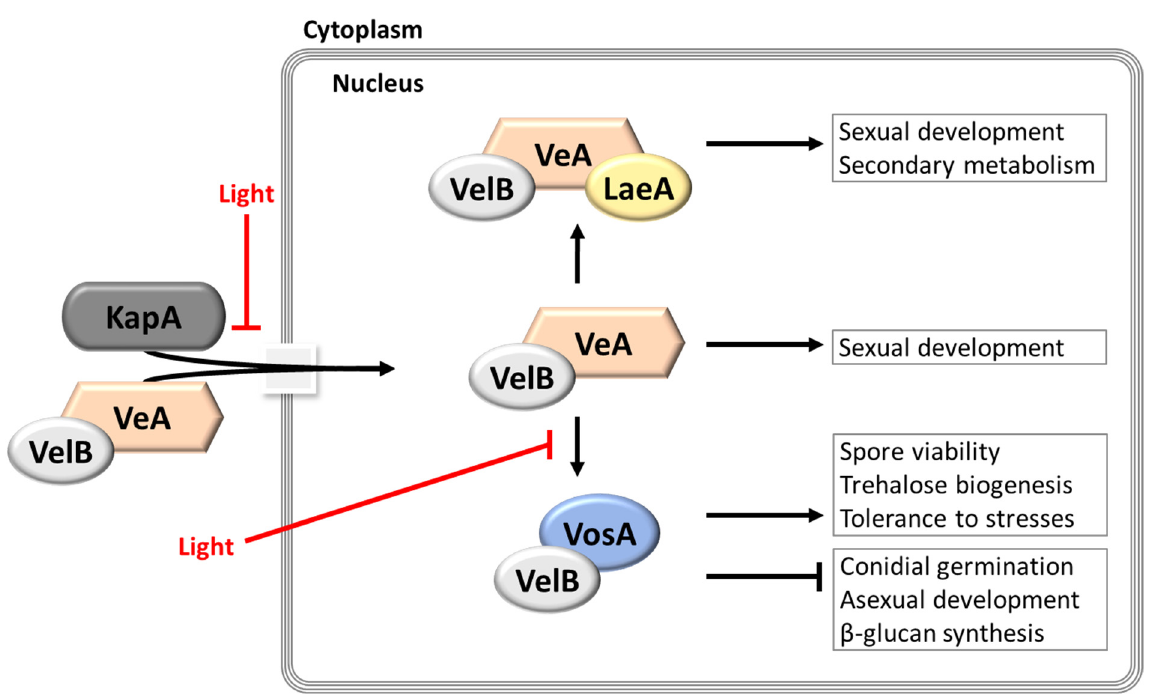
Figure 5. The functions of velvet family proteins in Aspergillus species. This model is adopted and modified from [82]. VeA enters the nucleus together with VelB and the importin- α KapA in the dark. In the nucleus, velvet family proteins and LaeA can form three different complexes depending on the presence or absence of light: VelB-VosA, VelB-VeA, and VelB-VeA-LaeA. These complexes regulate different biological processes.